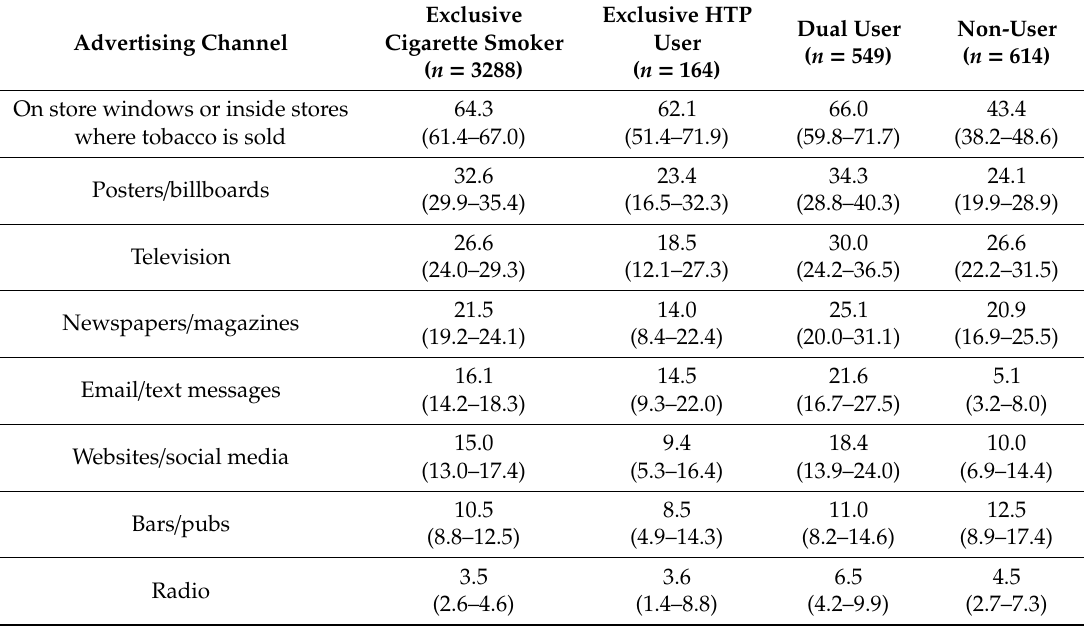
Table 3. Percentage of Respondents (and 95% CI) who Reported Noticing Advertising of Cigarettes in the Past Six Months by Channel and User